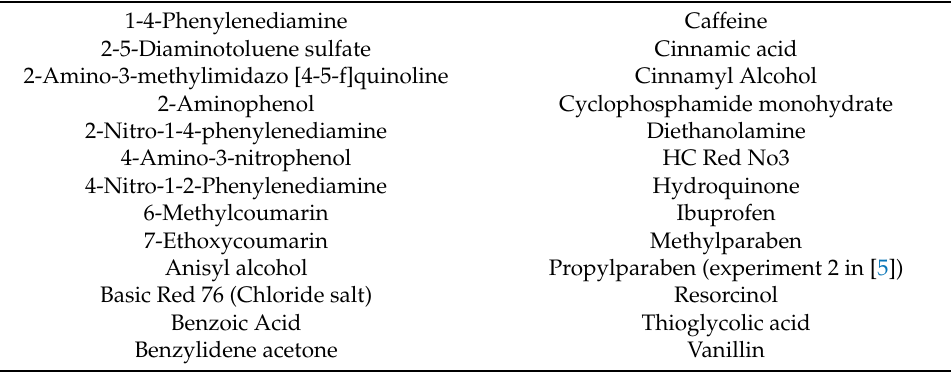
Table 1. Compounds tested in PBS solvents in [5] and selected for model assessment.